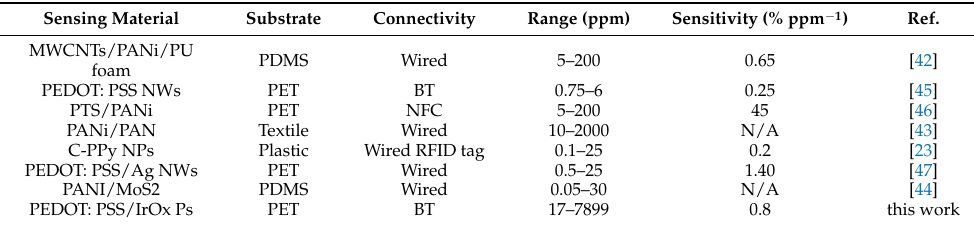
Table 1. Summary of flexible NH 3 gas sensors performances, based on conducting polymers reported in the